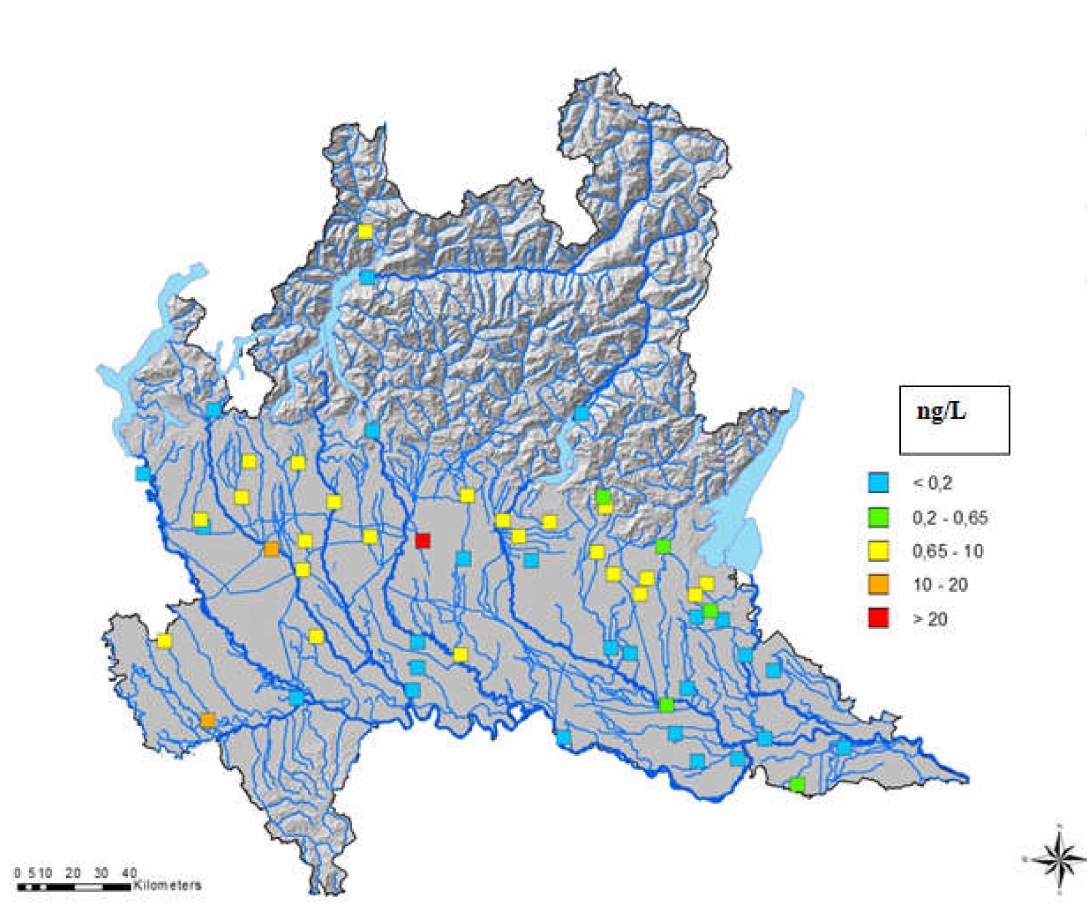
Figure 2. PFOS distribution in ground water samples in Lombardia